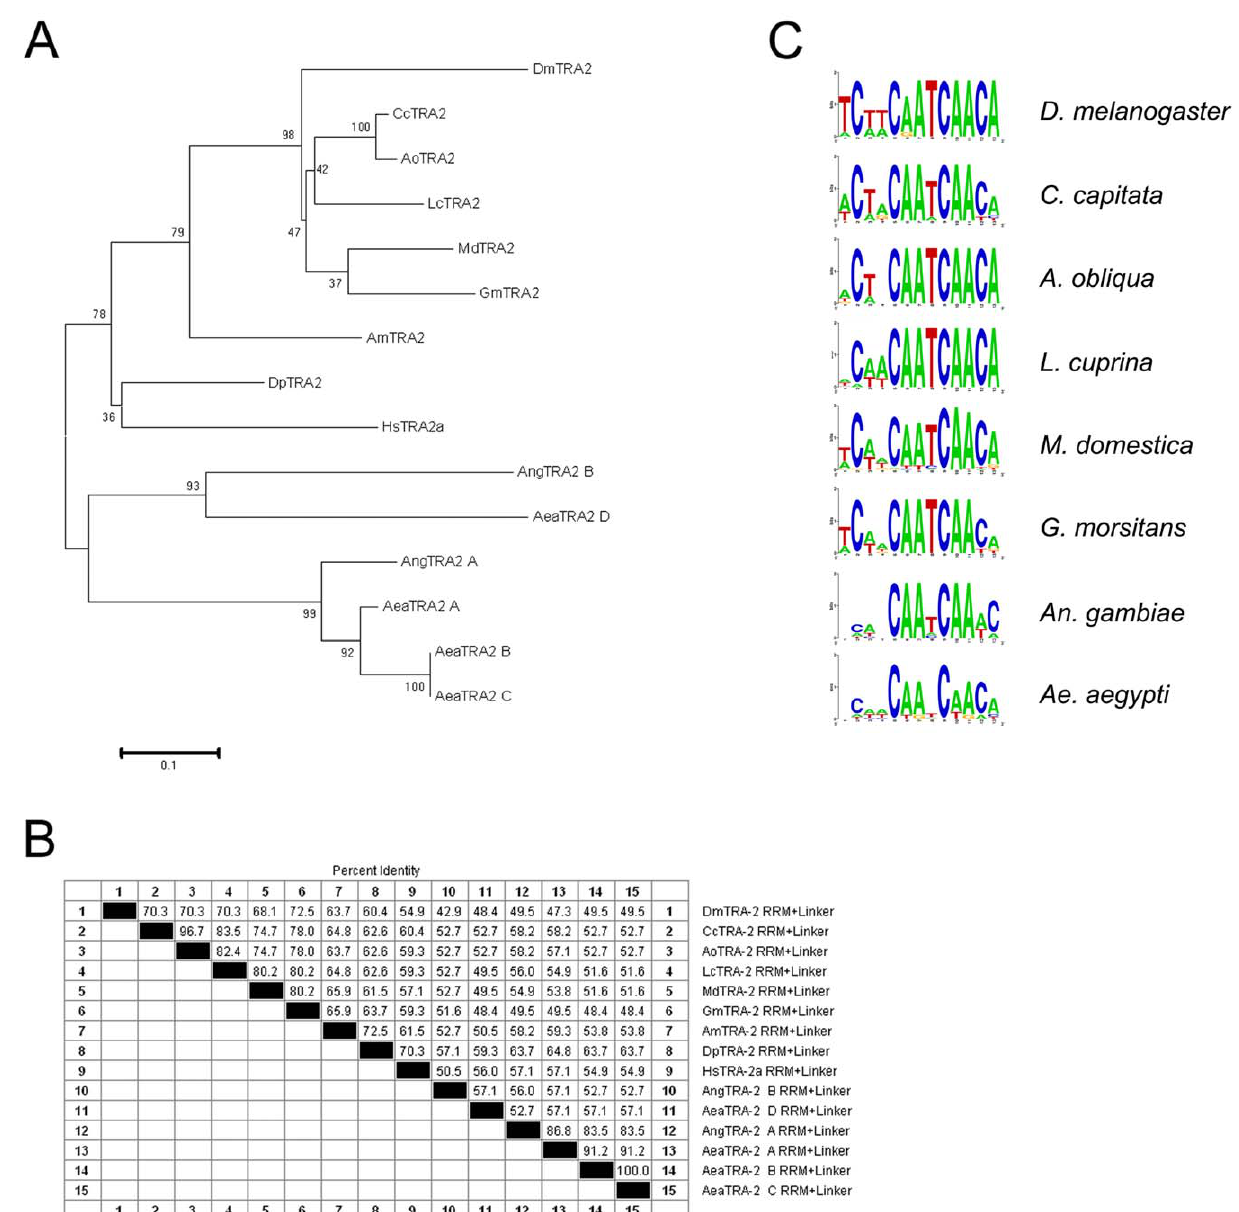
Figure 7. Phylogenetic and molecular evolution analyses of tra-2 in mosquitoes. (A) NJ consensus tree based on nucleotide alignment of the RRM + Linker encoding regions of the tra-2 gene of different insect and non insect species. (B) Table with the percentage of identity of the same nucleotide sequences analysed in the NJ tree. (C) WebLogo consensus sequences of TRA/TRA-2 binding sites of the indicated species. Only for mosquito species is it not possible to define a clear consensus